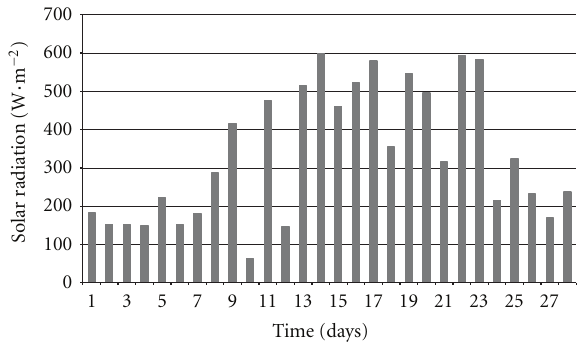
Figure 5: The course of insolation during the summer cycle (July).